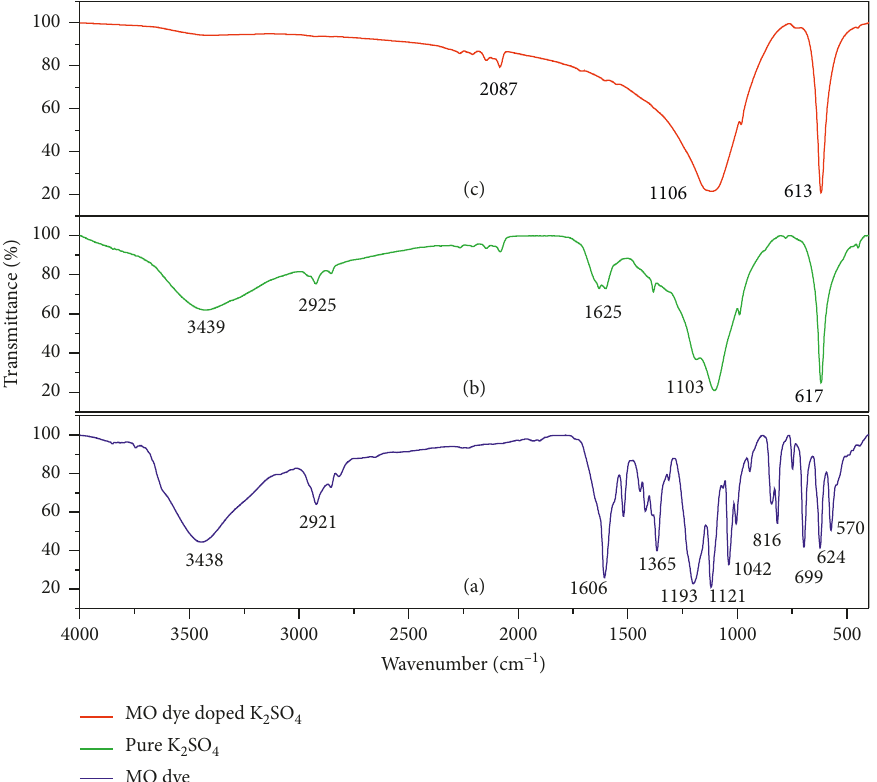
2 SO 4 single crystal.